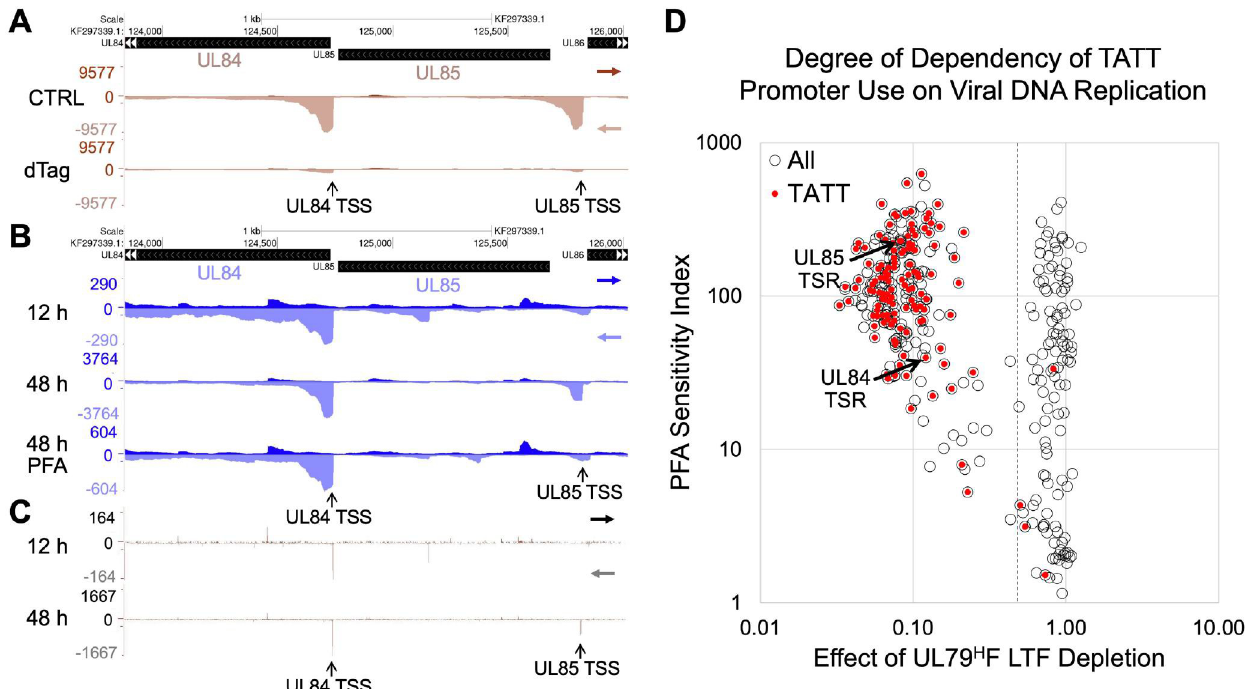
Fig 6. The UL79 LTF initiates transcription at TATT-containing viral early-late and late promoters. ( A-C ) Genome browser views of PRO-Seq-Flavo results for TATTTAA-containing UL84 and UL85 promoters. Spike-in normalized reads from Pol II nascent transcripts are aligned to the HCMV TB40/E KF297339 genome. ( A ) HCMV TB40/E UL79 H F infection for 72 h treated with 6-h dTag vs. CTRL. ( B and C ) HCMV TB40/E WT infections for 12 and 48 h (in absence or presence of PFA). Panel C is a map of 5’-ends of the same reads aligned in panel B for 12-h and 48-h infections without PFA. Vertical arrows point to positions of UL84 and UL85 MAXTSS. ( D ) Scatterplot of PFA sensitivity index (PSI) vs. effect of UL79 H F LTF depletion on TSR strength (dTag vs. CTRL treatments) for 320 viral TSRs � 435 nascent RNA reads (open circles). Viral TSRs having a TATT positioned -40 to -28 upstream of the MAXTSS are marked in red. PSI = ratio of TSR reads for PFA treatment/CTRL treatment of 72-h HCMV TB40/E WT infection. Effect of UL79 H F LTF depletion (dTag/ CTRL reads) is described in Fig 3B. Dashed line denotes 0.5 dTag/CTRL read breakpoint. Arrows point to UL84 and UL85 TSRs, with PSIs 40 and 220,